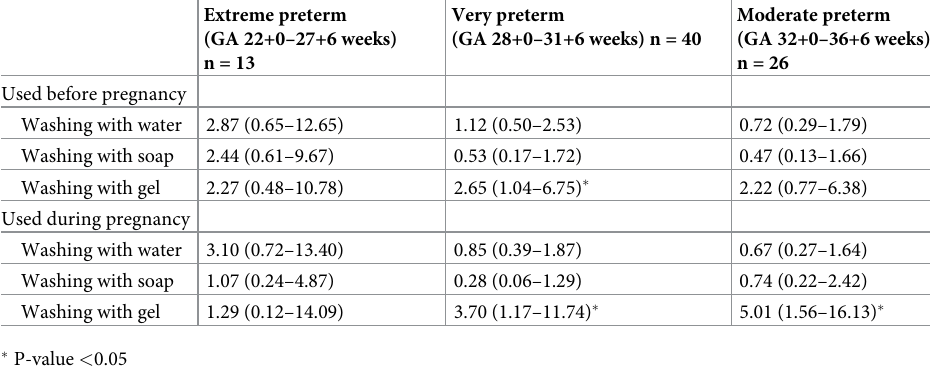
� P-value < 0.05 Adjusted for age, level of education, Caucasian, primiparas, and previous preterm delivery.